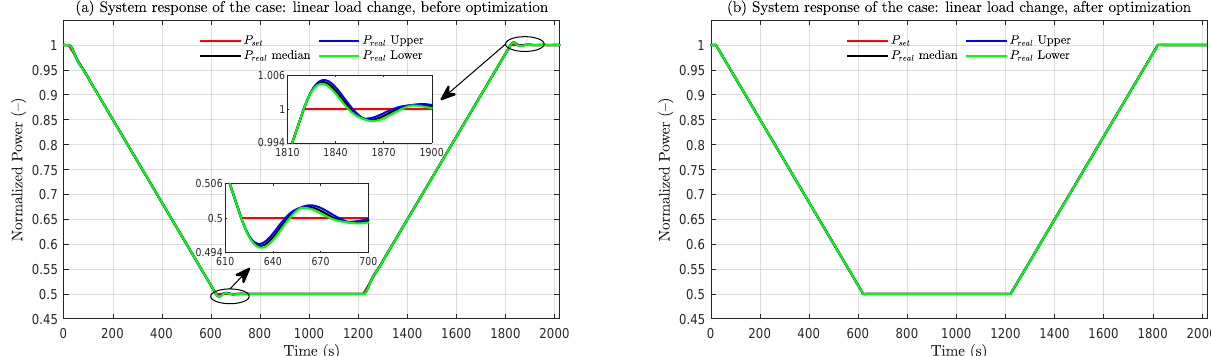
Figure 19. System responses of the case of linear load change: ( a ) before optimization; ( b ) after